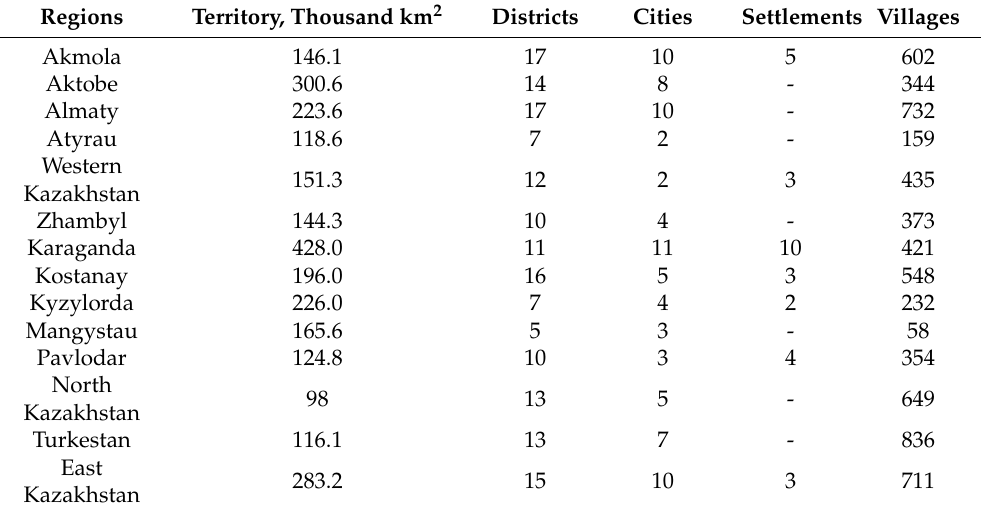
Table 1. Administrative–territorial structure of Kazakhstan in 2021 [19].